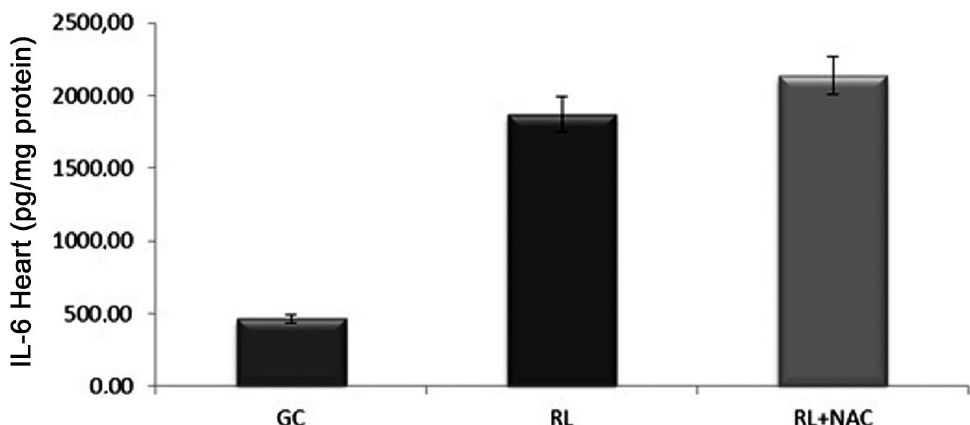
Fig. 2 - Interleukin 6 expression in cardiac tissue for the control group (CG), Ringer Lactate group (RL) and Ringer lactate with N-acetylcysteine group (RLNAC). * Significant difference when compared to CG, (P<0.05) .